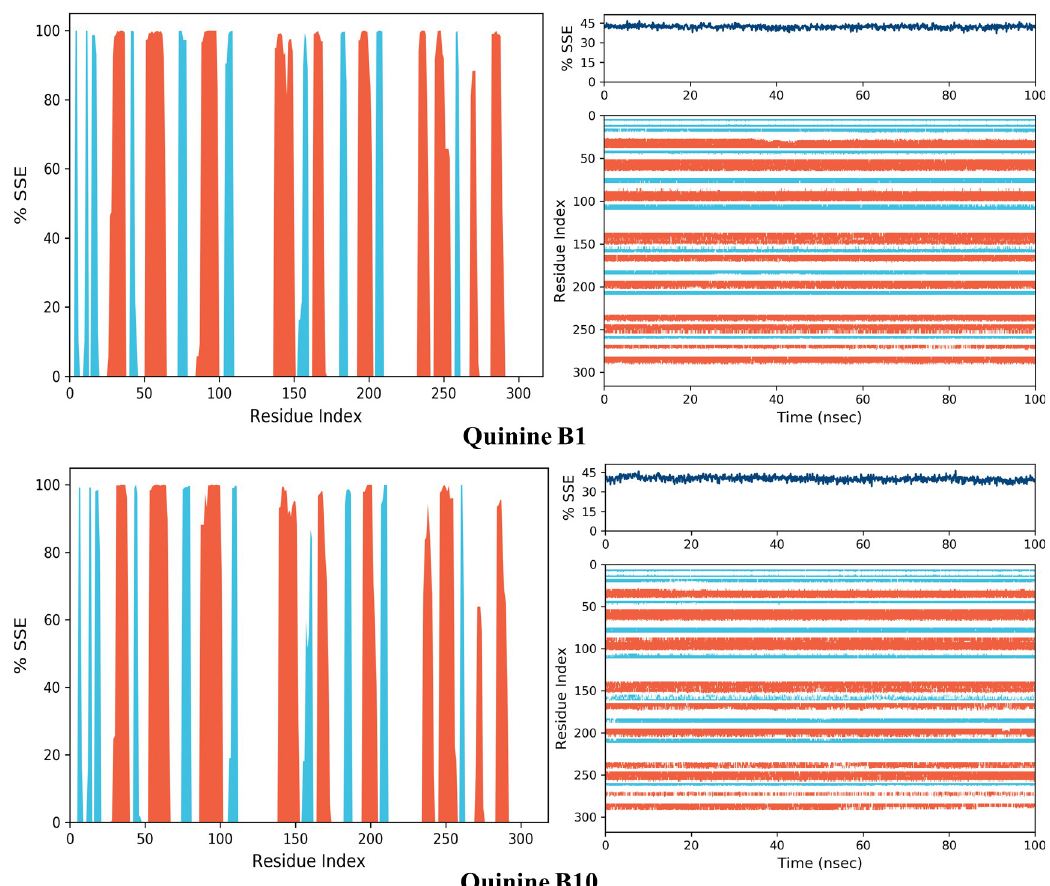
Fig 18. AKR1B1, AKR1B10 bound with quinidine secondary structure element distribution by residue index. The colours red and blue represent alpha helices and beta strands, respectively.